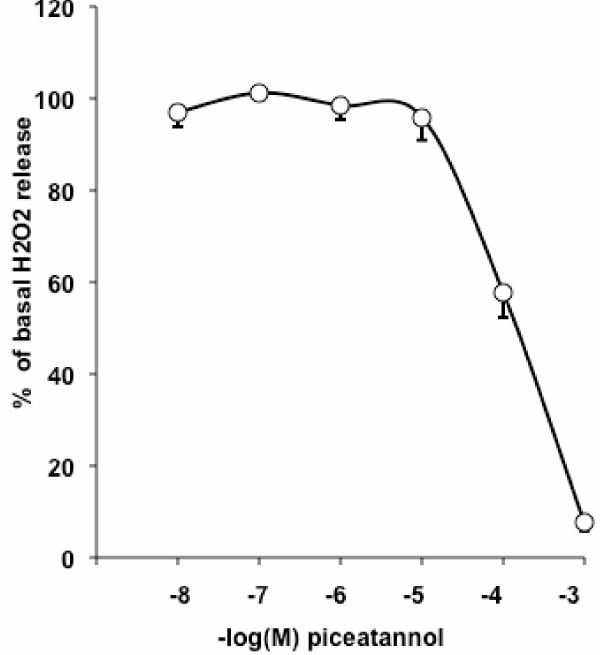
Figure 8. Inhibition of hydrogen peroxide detection by piceatannol in human adipose tissue (AT) preparations. Mean ± SEM of five